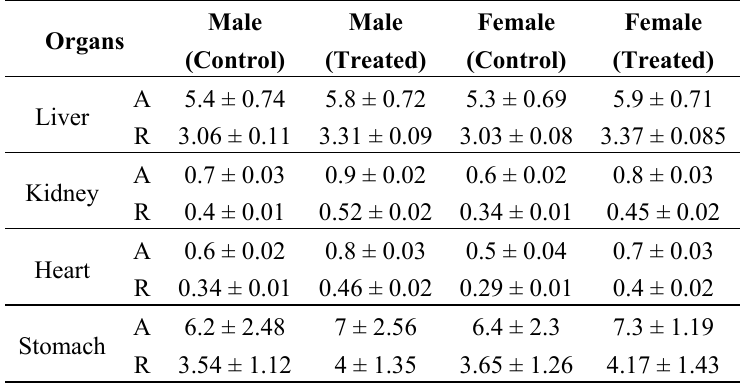
Table 4. Absolute (g) and relative (%) organ weights of Wistar rats administered with tomato powder suspension for 28 consecutive days.